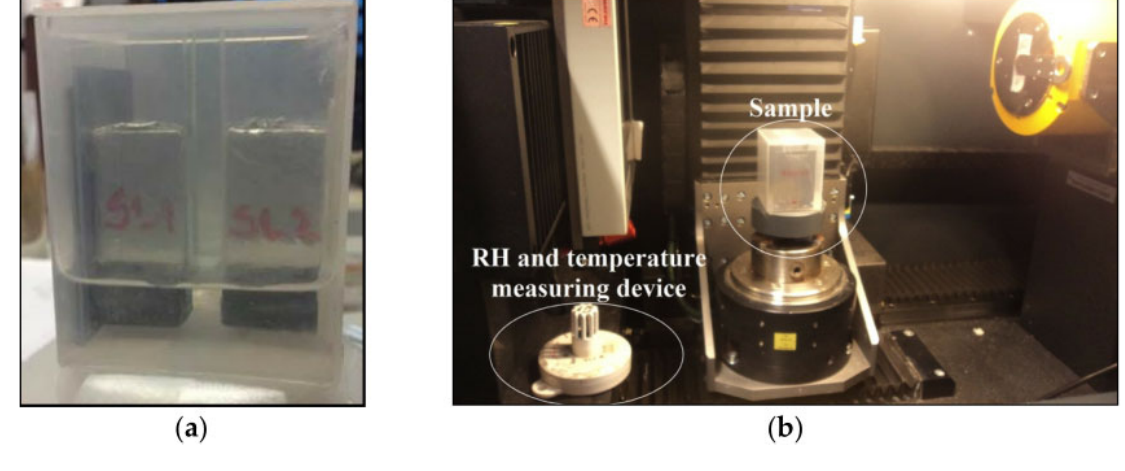
Figure 15. Sample for moisture exchange measurements; ( a ) two specimens are placed in a plastic container pior to X ‐ ray testing; ( b ) the X ‐ ray system with the position of the sample and temperature and RH sensors [77]. (Adapted and reprinted with permission from ref. 77, © 2015, Materials (Ba ‐ sel).).